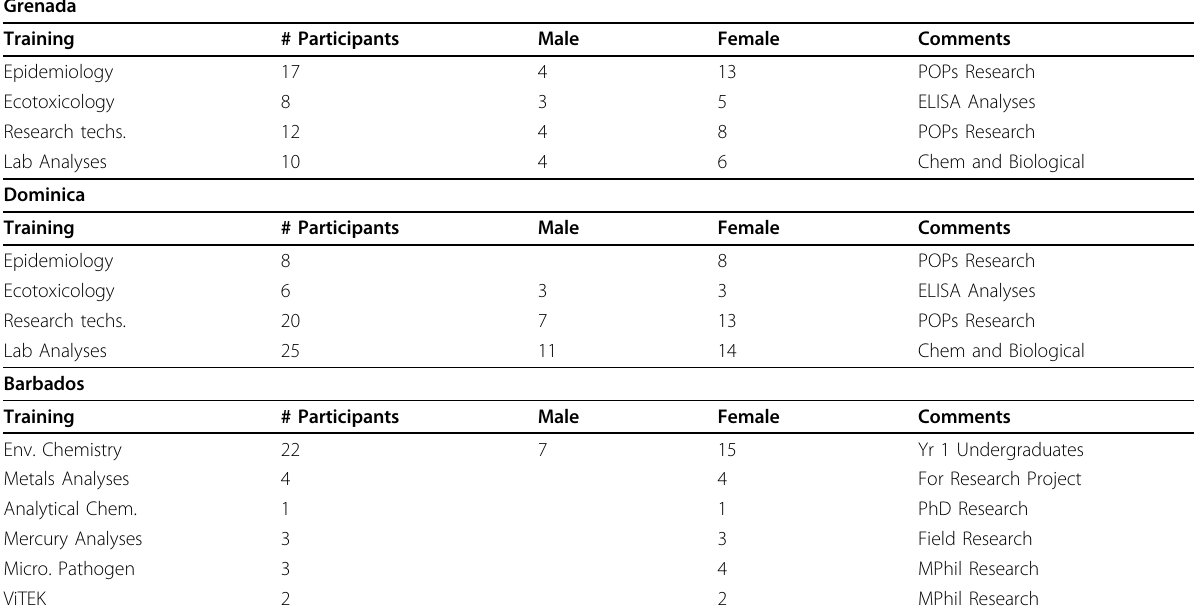
Table 2 Human resource development and enhancement through the Caribbean Ecohealth Programme ’ s Atlantis Mobile Laboratory